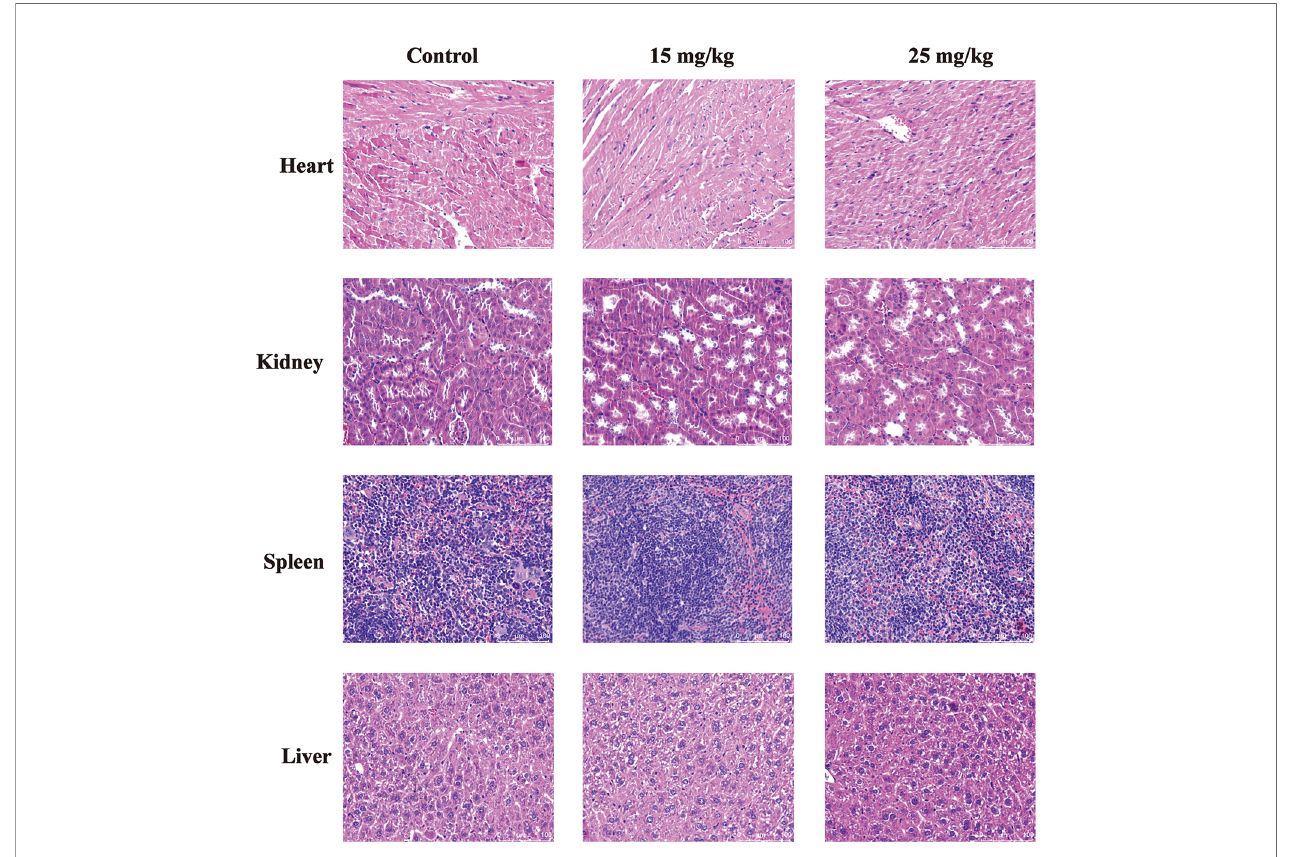
FIGURE 7 | The toxicity of sophoridine on the heart, liver, kidney, and spleen tissues in vivo . The sections were stained with H&E staining. The pictures are representative from control and 15 and 25 mg/kg sophoridine